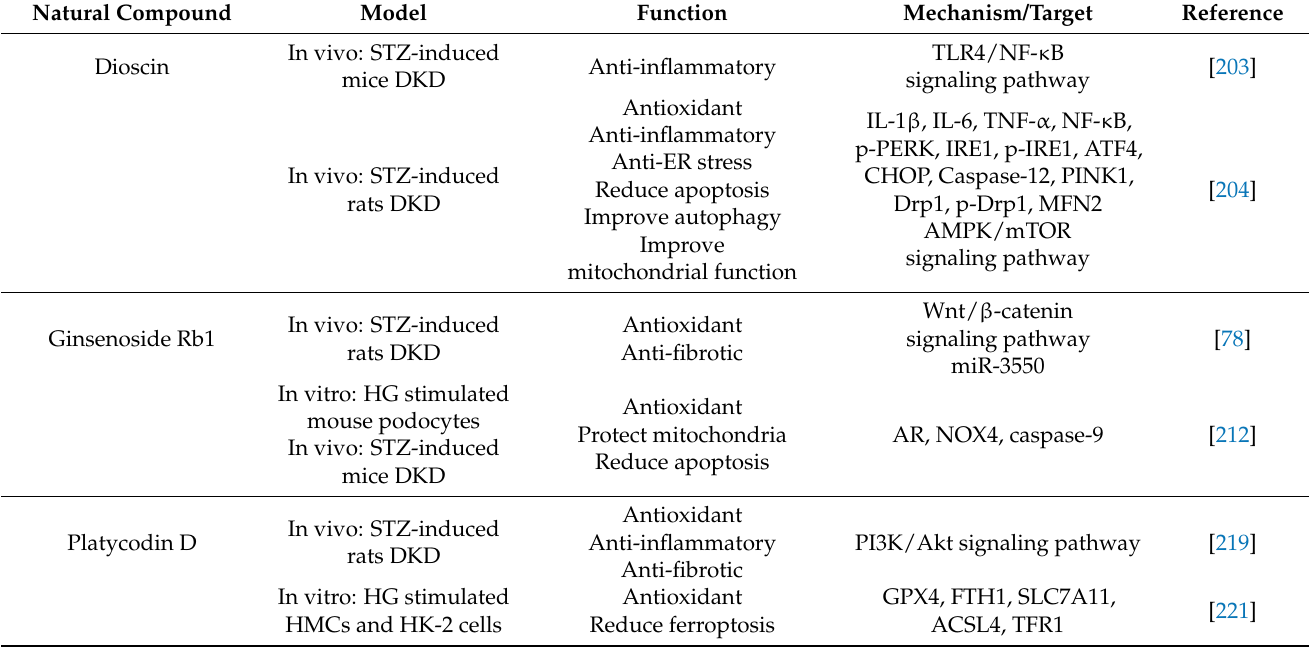
Table 5. Mechanisms of saponins in the treatment of